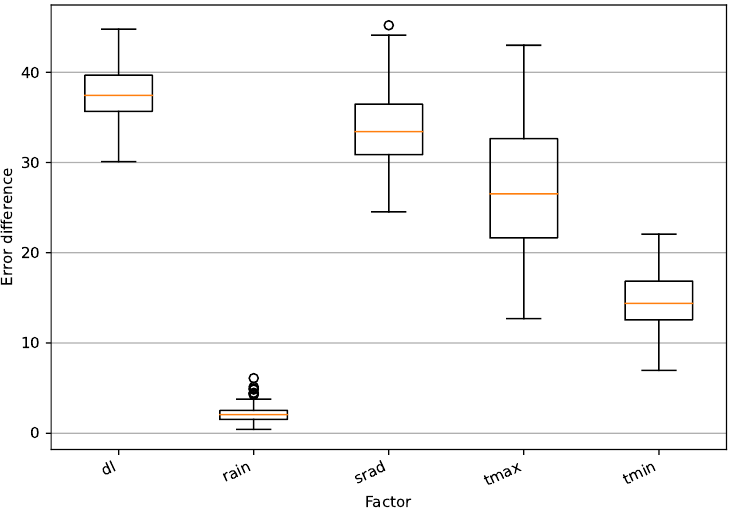
Figure 6. Impact of climatic factors to the model solution calculated by permutation test. The boxplots show the difference in root mean squared score in respect to days from planting to